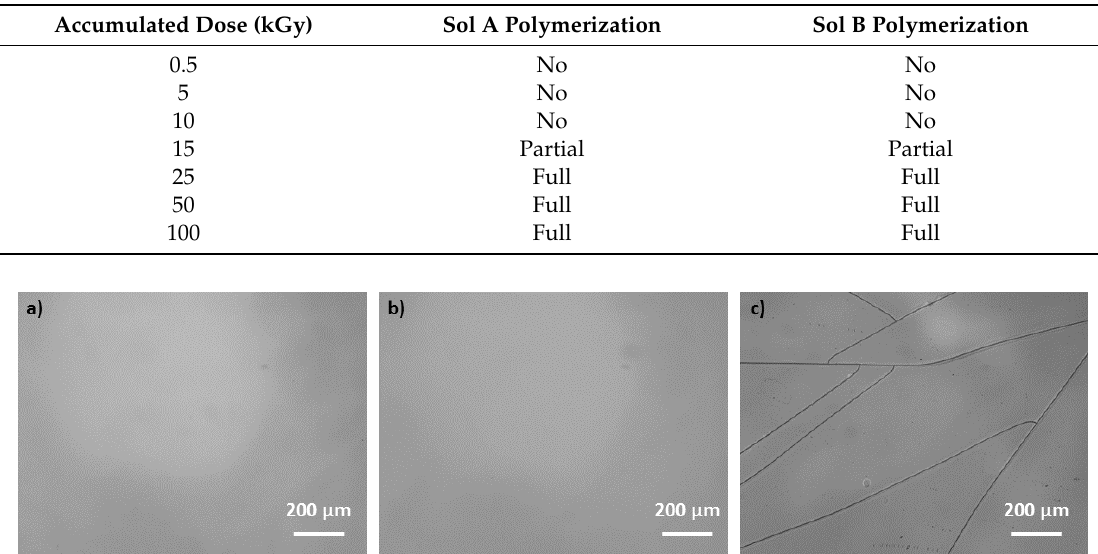
Figure 4. Microscope images (X10) of silica-titania sol–gel layers obtained in reflexion mode for: ( a ) sol–gel irradiated with UV photons (180 J / cm 2 ), ( b ) sol–gel irradiated with 40 keV hard X-rays at a 100 kGy accumulated dose, and ( c ) baked sol–gel at 90 °C during 2 h (no light exposure).